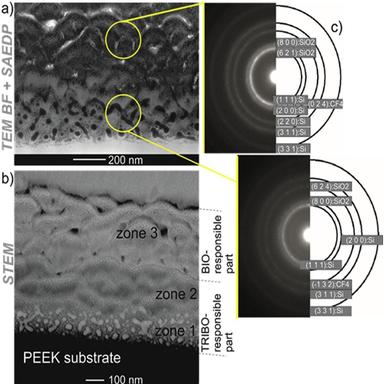
Microstructural characterization of the PTFE + SiO2/silicone multilayer coating on the PEEK substrate: a). TEM BF image of the coating along the crosssection; b). STEM image of the coating along the cross-section; and c). phase analysis of the coating performed by SAEDP.